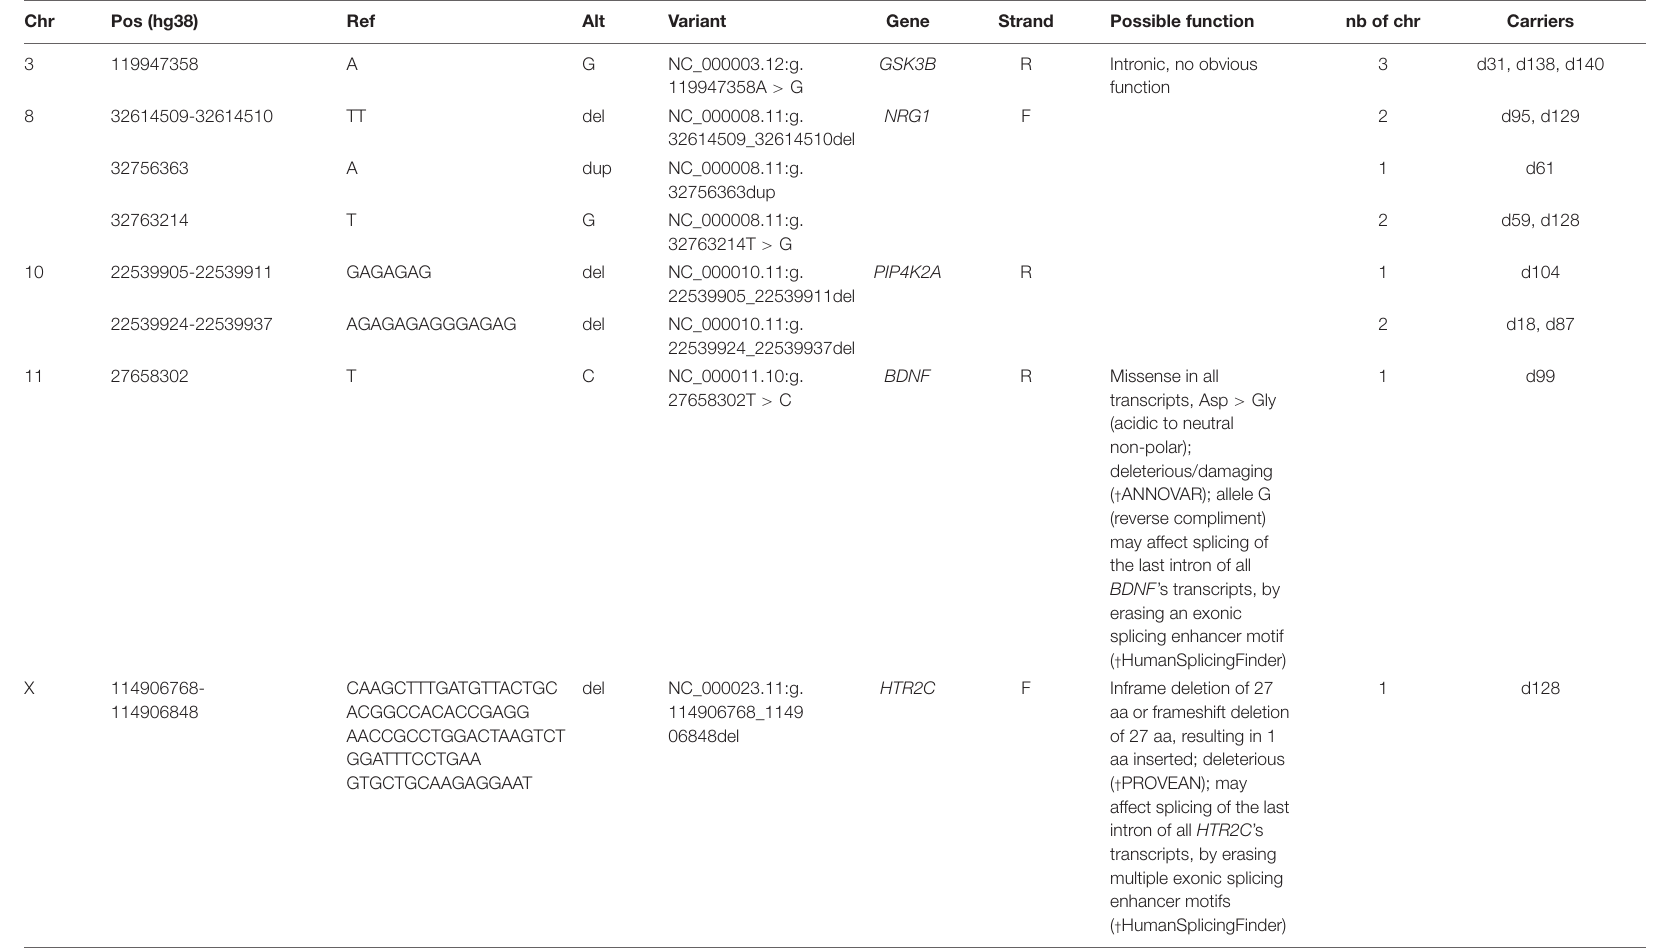
TABLE 3 | Novel variants discovered by